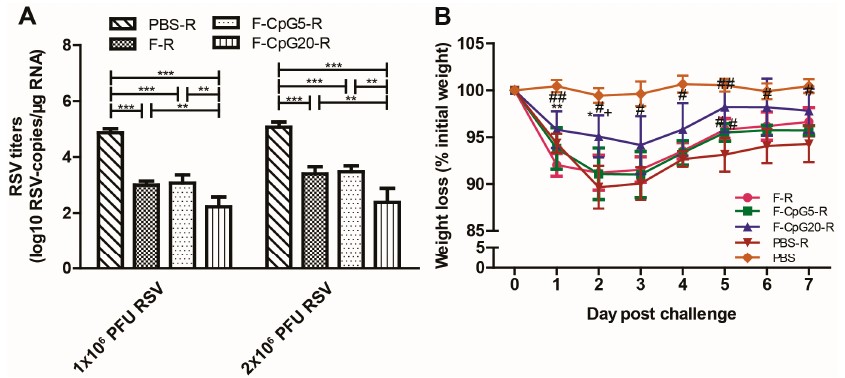
Figure 3. Lung virus titers and body weight changes in vaccinated mice after RSV challenge. BALB/c mice ( n = 5) were immunized 4 times via (i.m. route with either pVAX1-F (30 μ g/dose/mouse), pVAX1-CpG5-F (30 μ g/dose/mouse), pVAX1-CpG20-F (30 μ g/dose/mouse), or PBS (NC, 100 μ L/mouse). ( A )